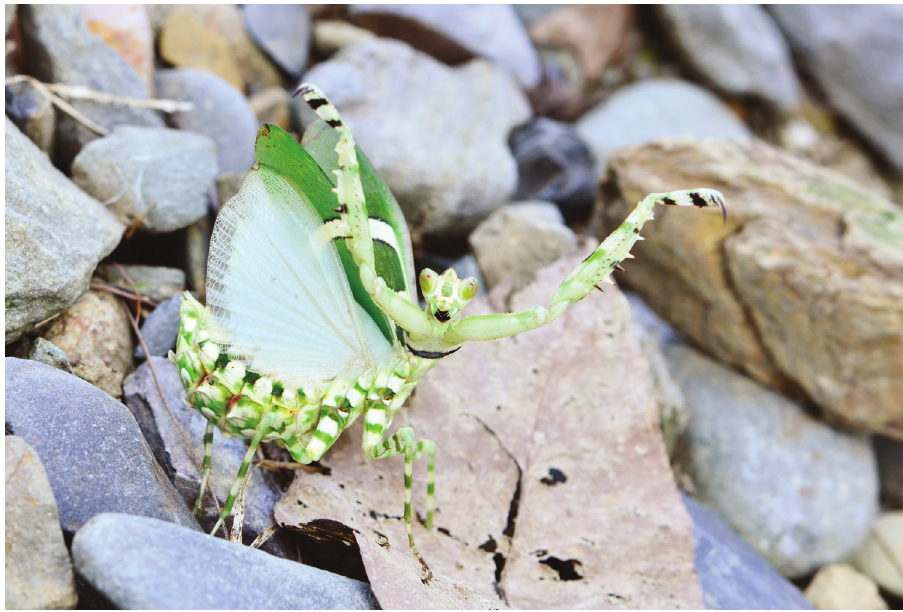
Figure 1. Female Theopropus sinecus sinecus in natural habitat, from Guangxi.